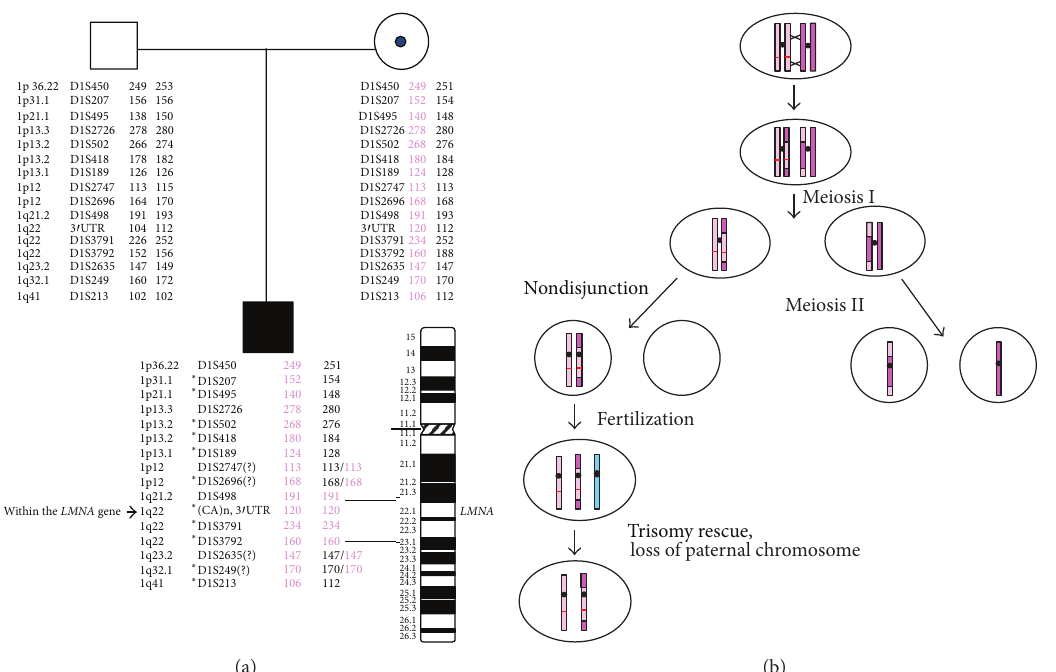
Figure 3: Uniparental disomy analysis of chromosome 1 and schematic representation of the generation of the homozygous p.M540T mutation. (a) Markers around the region of the LMNA gene in 1q22 show maternal isodisomy. Allele sizes for each marker are indicated. Informative markers for maternal UPD are denoted with an asterisk ( ∗ ). Based on the results, one recombination event could have occurred proximaltoD1S189at1p13.1andasecondrecombinationeventcouldhaveoccurredproximaltoD1S213at1q41resultinginmaternalisodisomy for the 1q21-q22 region where the LMNA resides. Due to the uninformative nature of markers D1S2747, D1S2696, D1S2635, and D1S249 in the mother, it is unclear whether these regions are isodisomic or heterodisomic. The uninformative markers are indicated with question marks. (b) Schematic representation of the generation of the homozygous p.M540T mutation in the patient by the process of recombination and nondisjunction in maternal meiosis followed by trisomy rescue. Nondisjunction is shown as occurring in meiosis II in this figure, but it could also have occurred in meiosis I; the microsatellite markers used could not distinguish between these two possibilities. The p.M540T mutation is indicated by the red bar on one of the maternal chromosome 1 󸀠 s. Paternal chromosome 1 is indicated by the blue colored. LMNA gene is indicated by the red